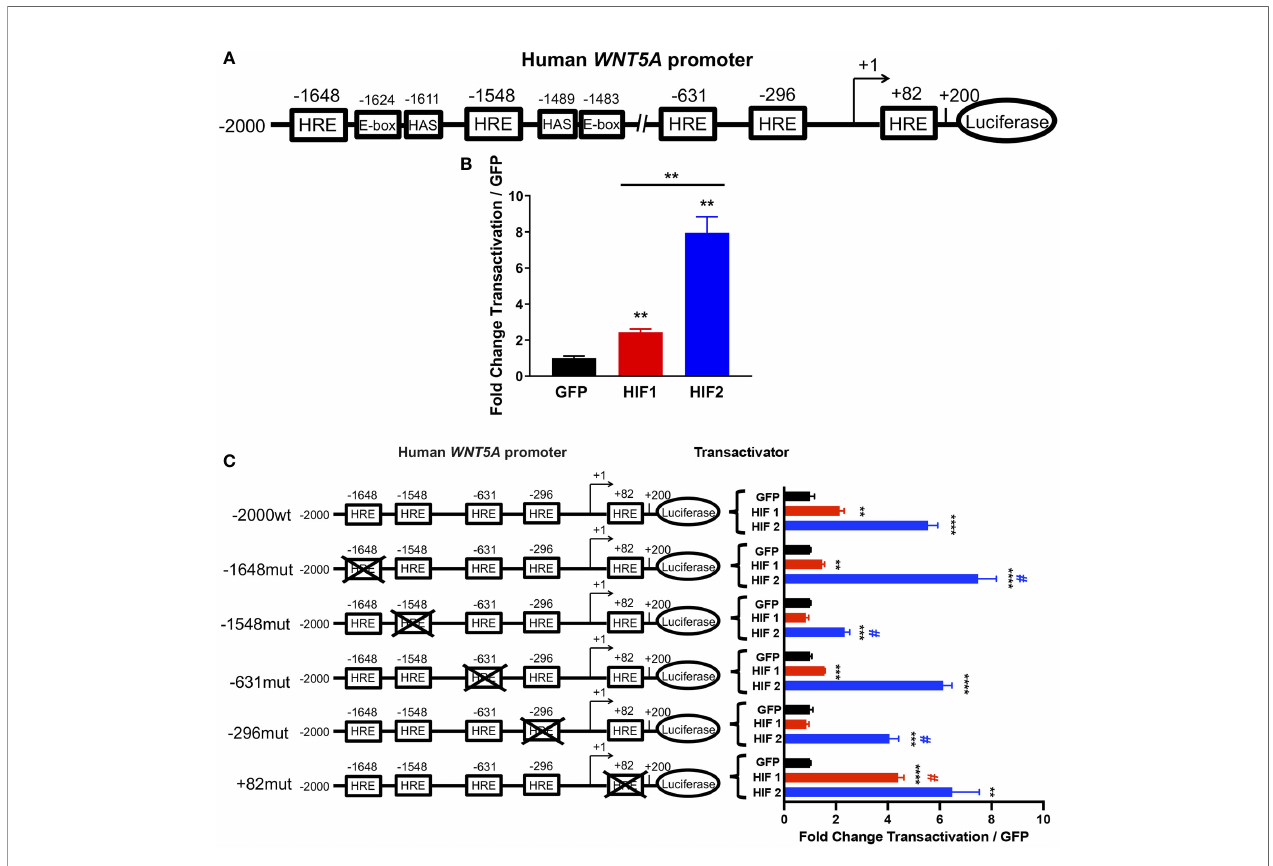
FIGURE 4 | HIF2 directly activates the WNT5A promoter via HREs. (A) Human WNT5A promoter scheme showing distal (-1648, -1548, and -631) and proximal (-296 and +82) HREs identi fi ed by sequence analysis. (B) Dual luciferase reporter assay in AD-293 cells with wild-type human WNT5A promoter-luciferase construct and transactivation by HIF1, HIF2, or GFP control plasmids (n = 4 transfections/group). (C) Dual luciferase reporter assay in AD-293 cells with human WNT5A promoter-luciferase construct containing wild-type sequence (-2000wt) or mutations of distal (-1648mut, -1548mut, -631mut) and proximal (-296mut and +82mut) HREs with transactivation by HIF1, HIF2, or GFP control plasmids (n = 4 transfections/group). All error bars represent mean ± SEM. Asterisks indicate comparison of HIF1 or HIF2 to their respective GFP controls. **P < 0.01, ***P < 0.001, ****P < 0.0001, by Student's t test with False Discovery Rate two-stage step-up approach. # indicates comparison of construct transactivation in wild-type sequence to mutated sequences by HIF1 (red #) or by HIF2 (blue #); P < 0.05, by two-way